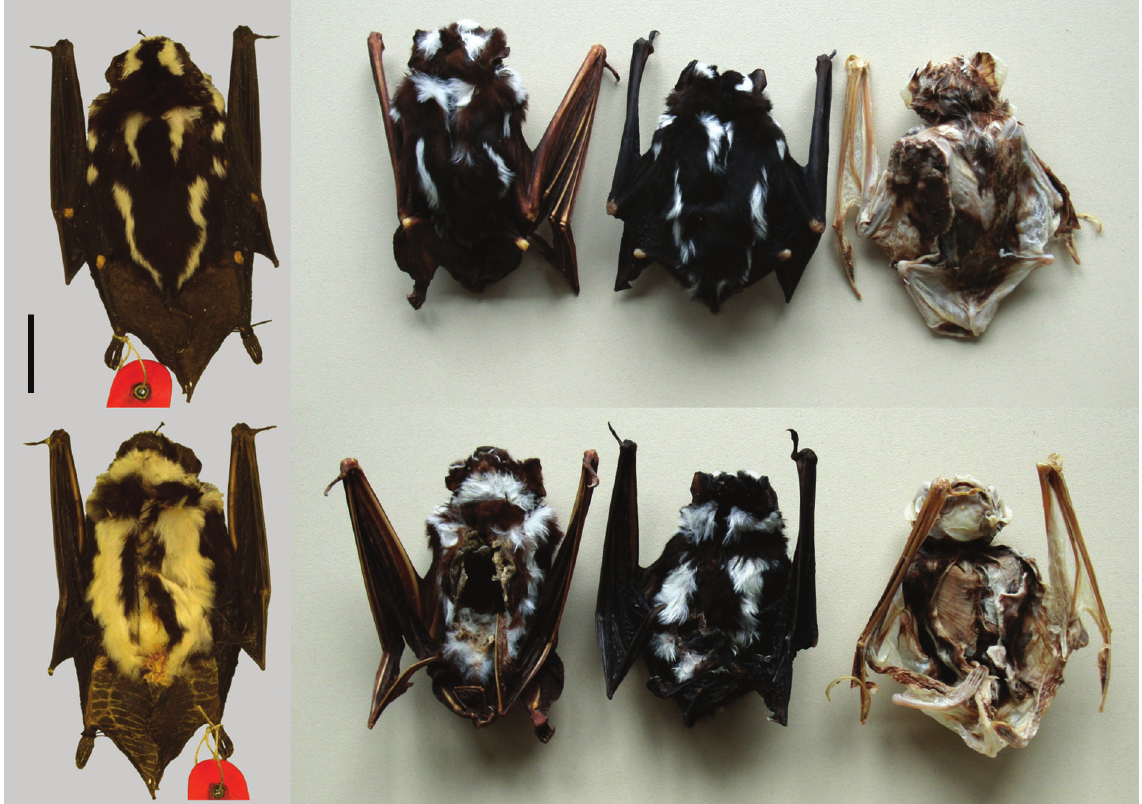
Fig. 3. Pelage pattern of the four known specimens of Glauconycteris superba Hayman, 1939 (upper row: dorsal, lower row: ventral). From left to right: holotype of G. s. sheila Hayman, 1947 (BMNH 47.10), holotype of G. superba (RMCA 14765), new specimen from Mbiye Island (RMCA a1.097-M-3153), and the specimen from Matonguiné (RMCA 97.077-M-7719). Scale bar = 2